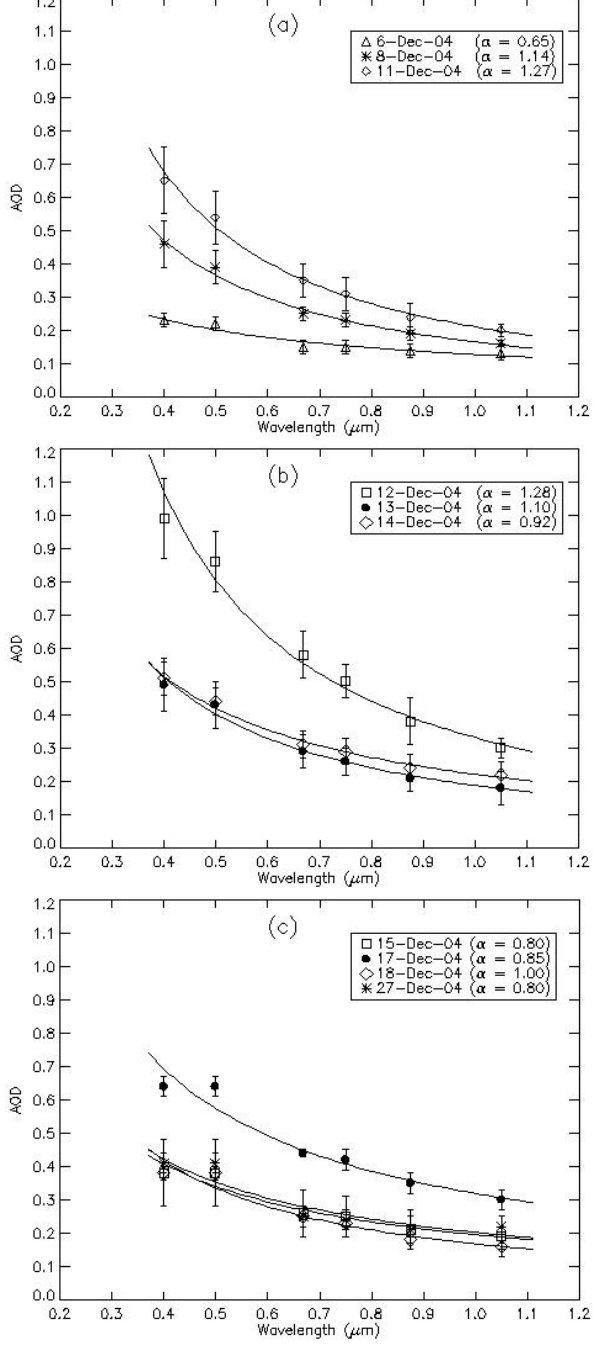
Fig. 3. Average aerosol optical depth (AOD) values obtained (a) prior to foggy days (6, 8 and 11 December 2006) (b) during foggy days (12, 13 and 14 December 2006, afternoon hours) and (c) after foggy days (15, 17, 18 and 27 December 2006). Measurements could not be made on other days due to cloudy sky conditions. Best fitted lines, drawn by a least-squares method, are also shown in the